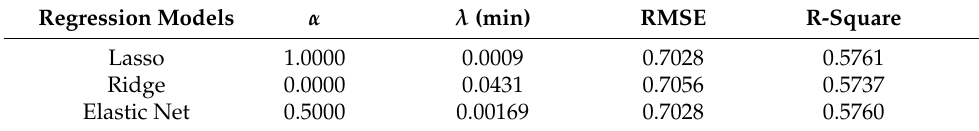
Table 6. Model parameter and evaluation metrics for penalized linear regression.